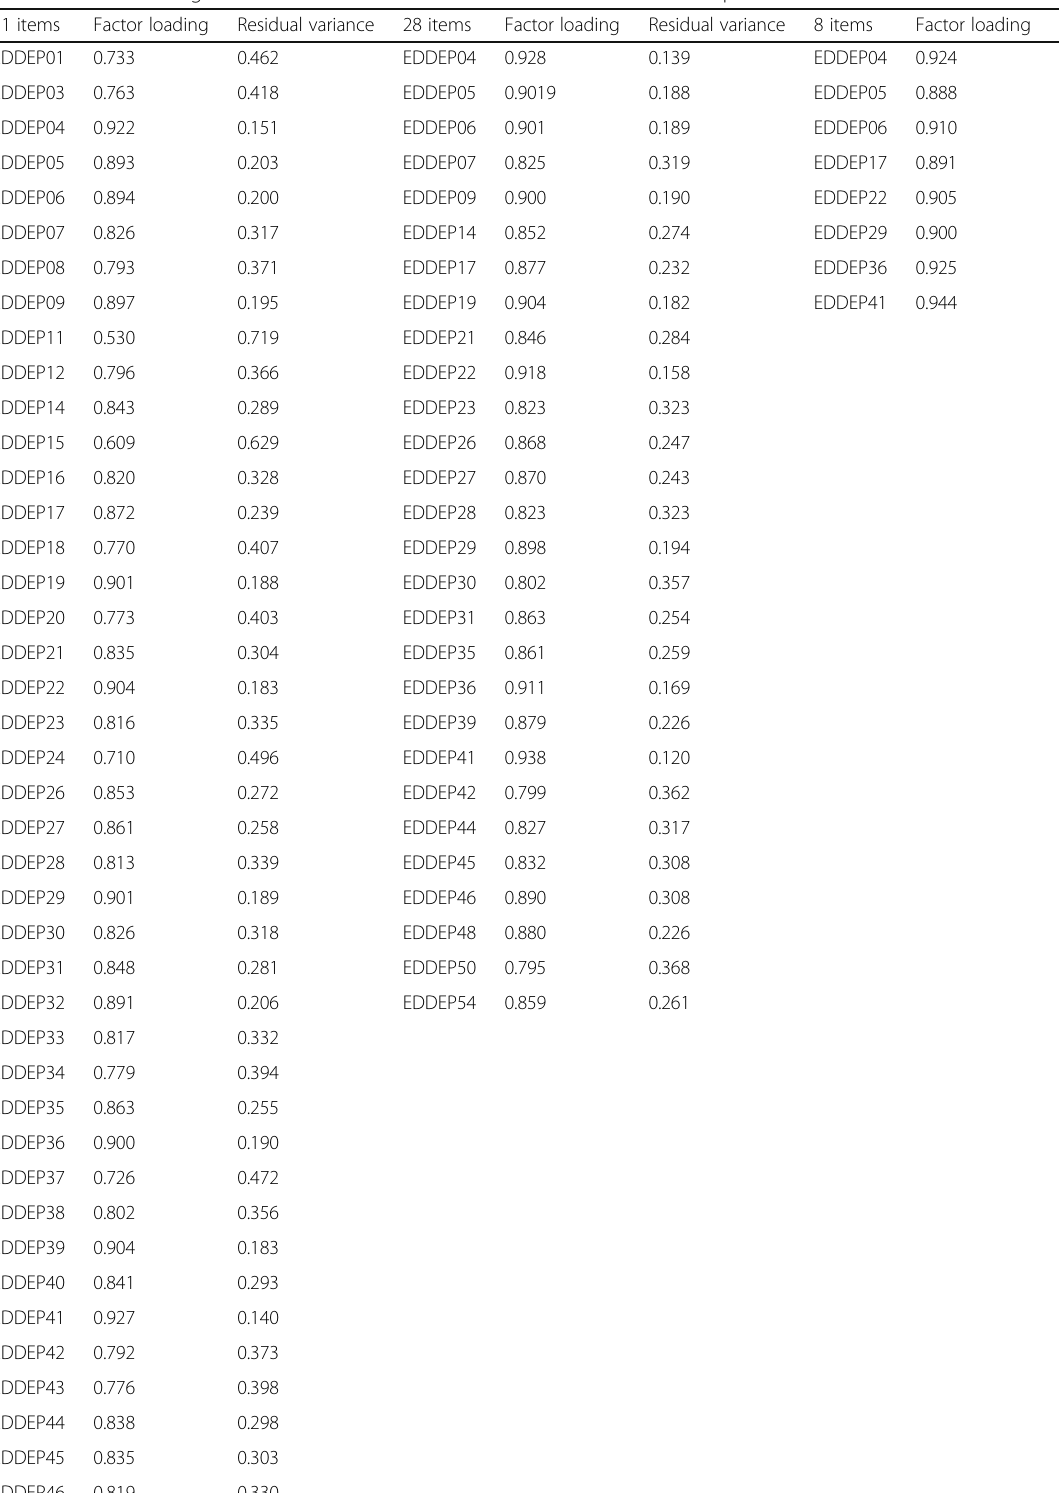
Table 3 Factor loadings for the unidimensional factor models of the PROMIS Depression Item